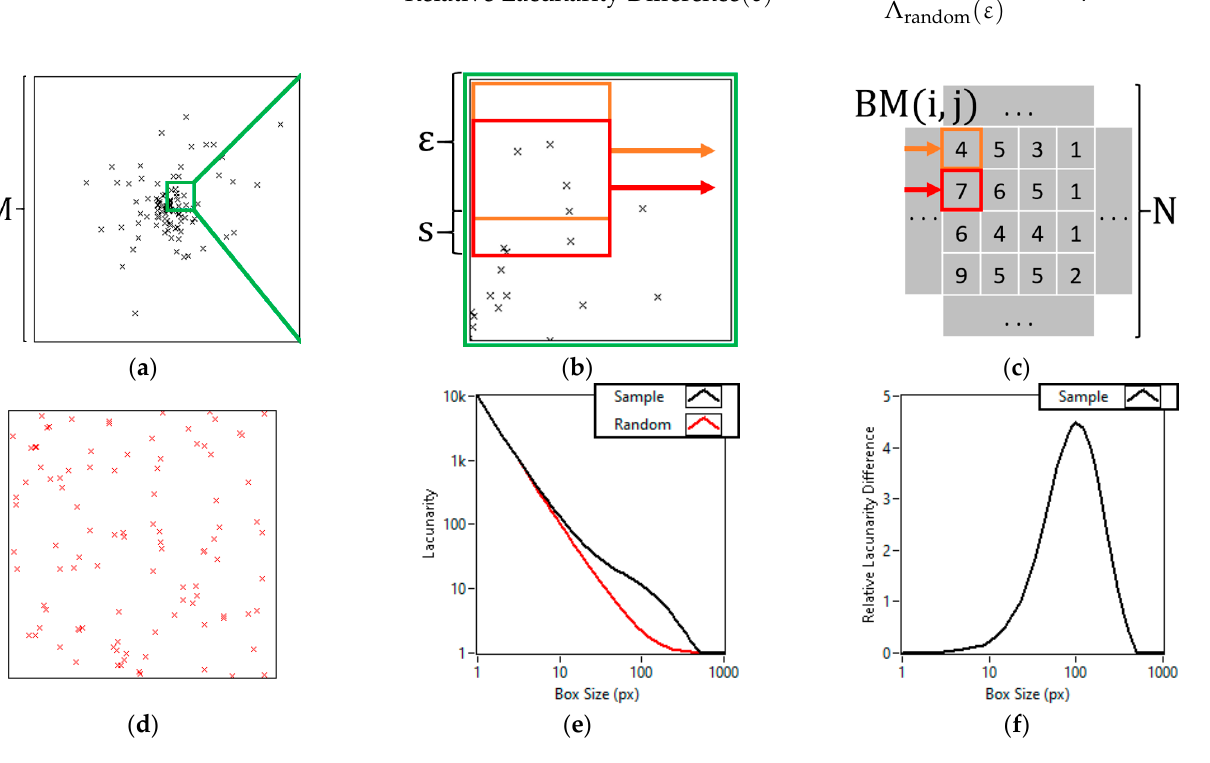
Figure 1. Step by step representation of the lacunarity calculation process and visualization. Local- ization cluster of a hundred localizations in a Gaussian distribution of 150 nm sigma on an area of 1000 nm by 1000 nm ( a ). Zoomed in on the cluster showing the gliding of an “ ε ” sized box at a step size of “s” ( b ). The box masses in the zoomed in area, calculated from the number of localizations in each box ( c ). Random set of a hundred localizations on the same area of 1000 nm by 1000 nm with an even distribution ( d ). Lacunarity curves of the cluster and the random dataset ( e ). Lacunarity difference curve created by calculating the relative difference between the lacunarity curve of the cluster and that of the random dataset of the same number of localizations at each point ( f ).